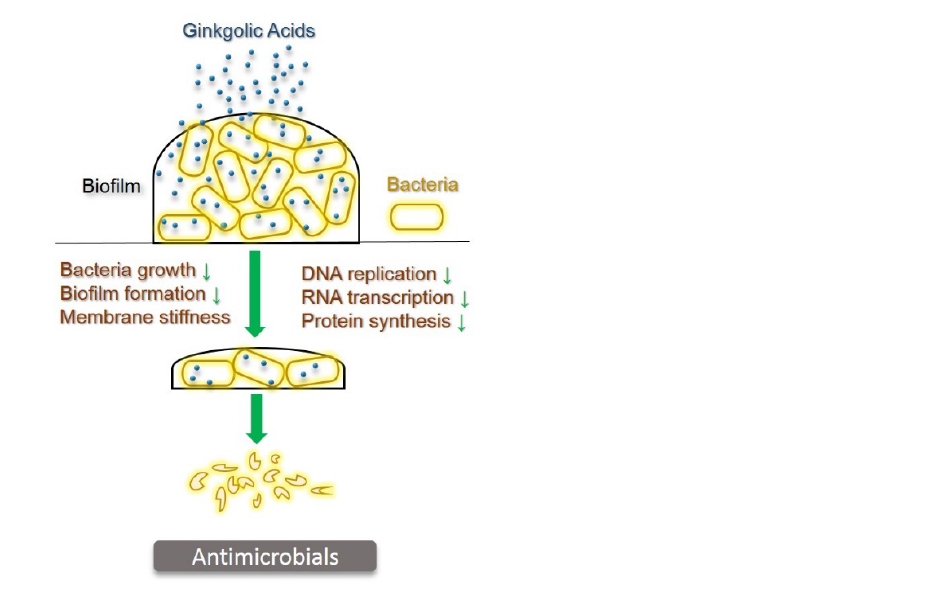
Figure 3. Antimicrobial activity of ginkgolic acids. Ginkgolic acids penetrate through biofilm and bacteria cell walls into cytoplasm to kill bacteria via inhibition of growth, biofilm formation, DNA replication, RNA transcription, protein synthesis, and induction of membrane stiffness.